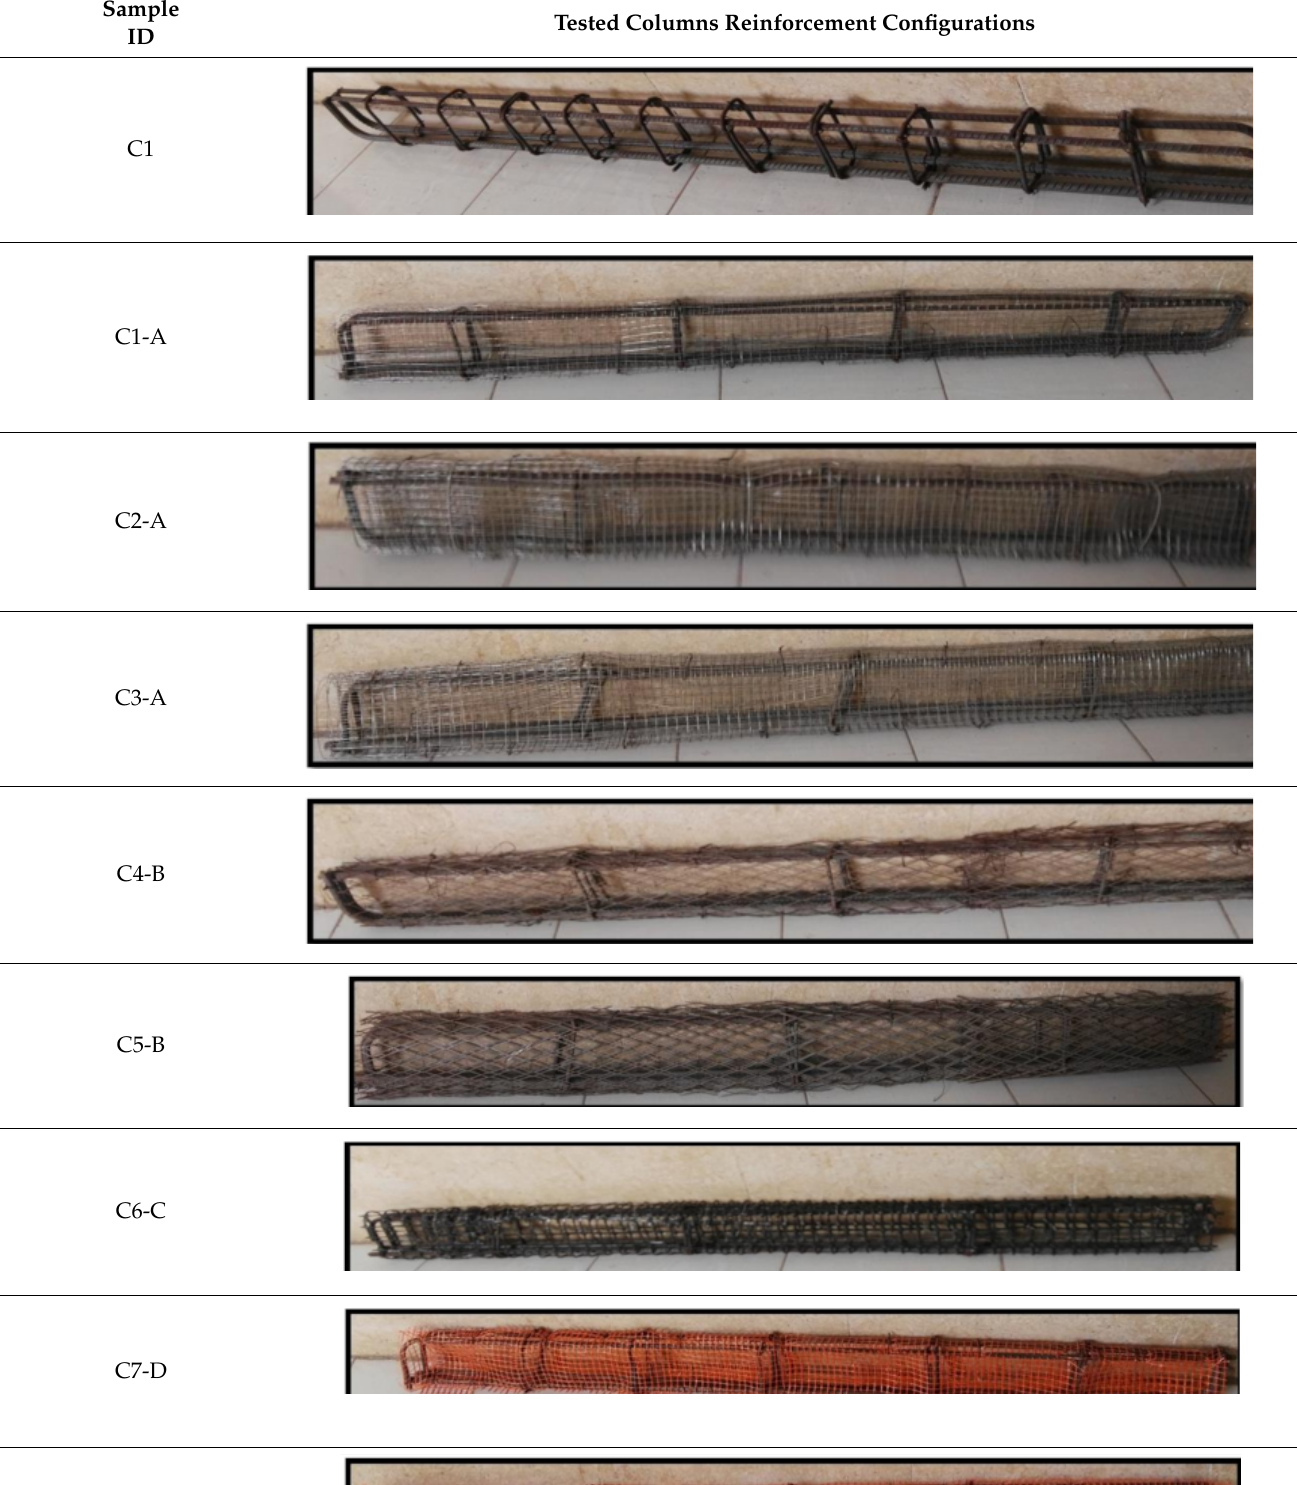
Table 6. Reinforcement configurations of the tested